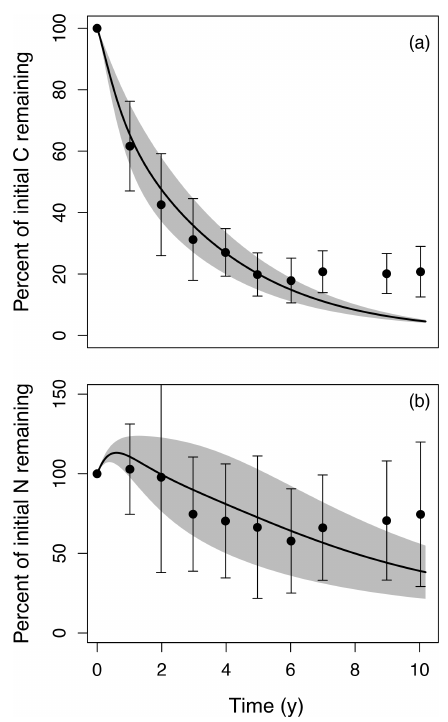
Figure 2. Litter decomposition time series simulated by MIMICS- CN (lines with shaded area) compared to observations (points and error bars) of (a) percent mass remaining and (b) percent of initial N remaining over 10 years for six different litter types at the Har- vard Forest LTER. Litter decomposition data came from the LIDET study (Parton et al., 2007; Bonan et al., 2013; mean ± 1SD). Spread in the observations and model is largely generated by the effects of initial litter quality on decomposition rates and N dynamics. Model parameters were calibrated to fit MIMICS-CN to observations from Harvard Forest (Table